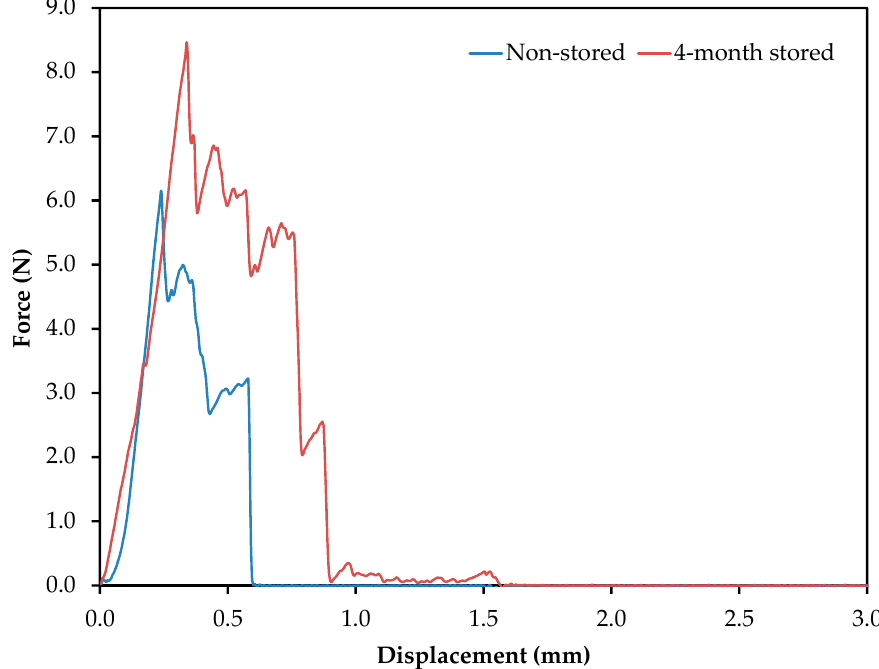
Figure 3. Force displacement curves generated from the analysis of potato crisps obtained from frying non-stored and 4-month stored tubers. Frying conditions: temperature, 150 °C; time, 5 min; no blanching treatment; and a slice thickness of 2.0 mm.